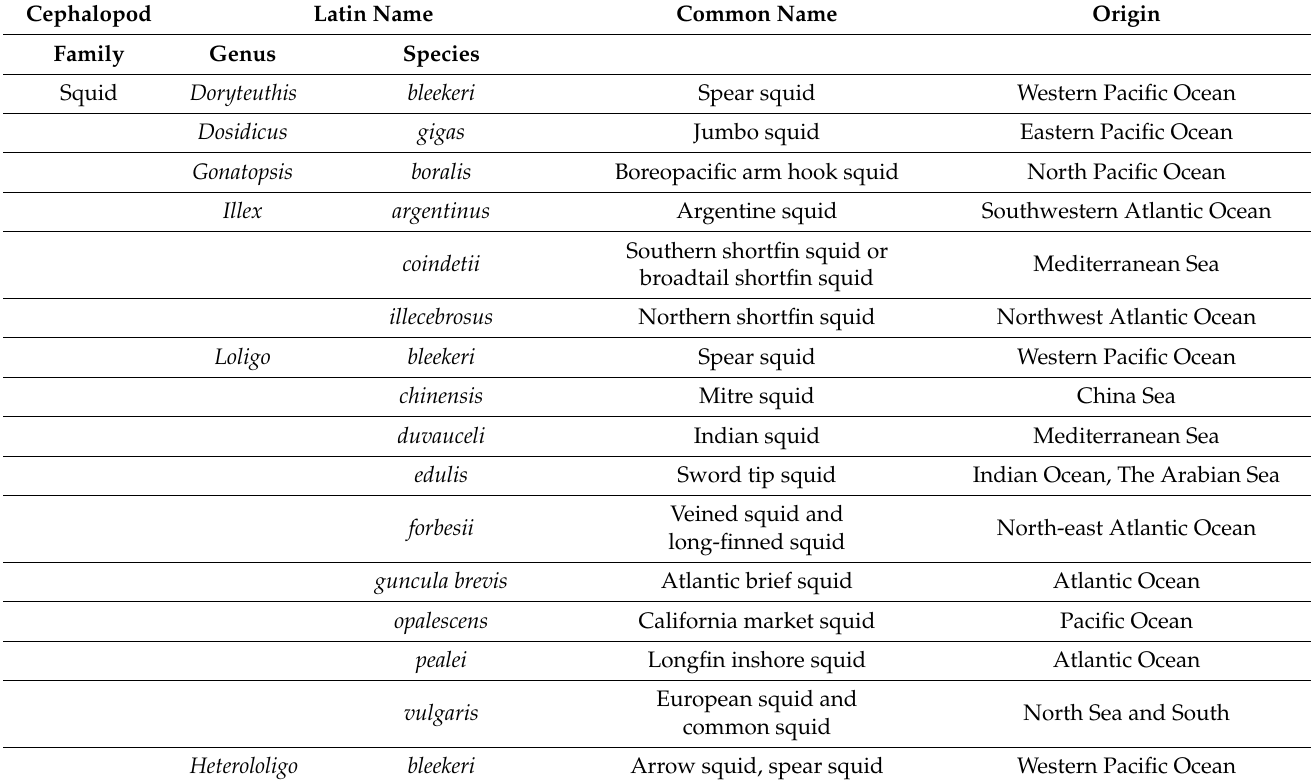
Table 1. Overview table of Latin and common names of some common species of cephalopods.